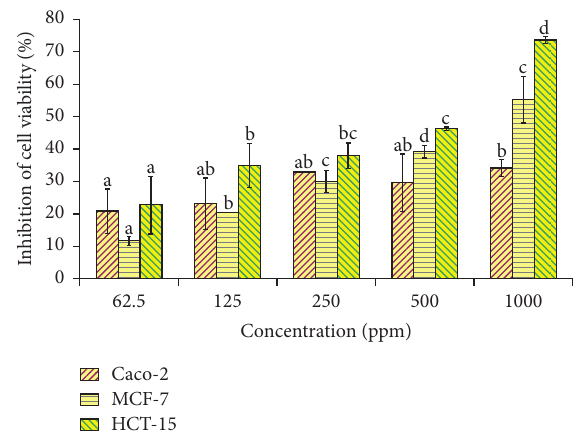
Figure 3: Cytotoxic activity of methanolic extract of stem against Caco-2, MCF-7, and HCT-15 cancer cell lines at different concen- trations. Values followed by different letters for each cell line are significantly different ( 𝑃 < 0.05 ) from each